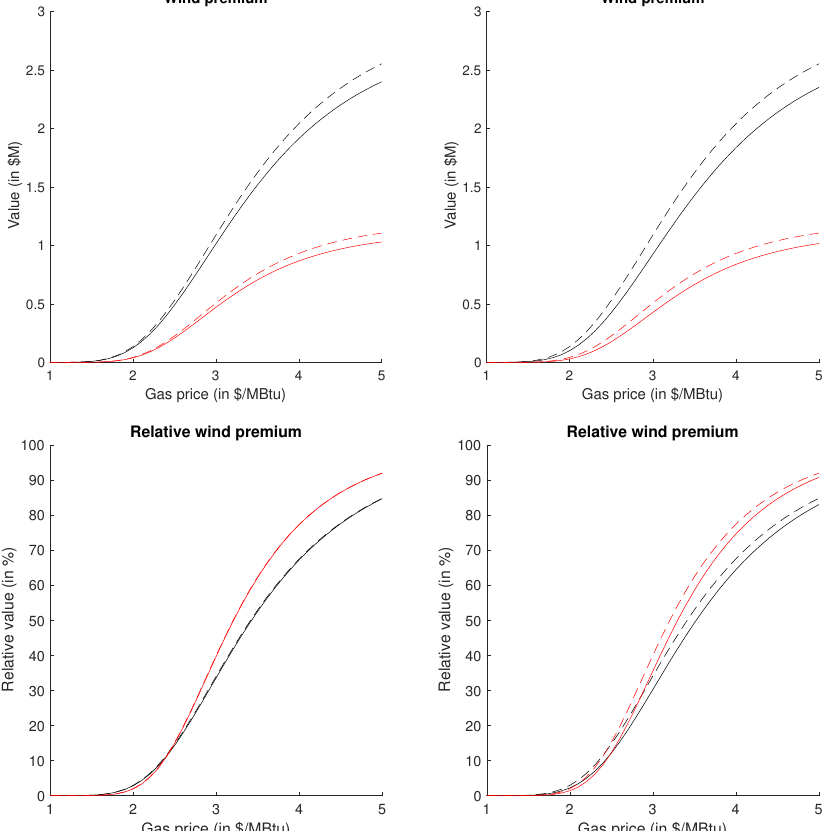
Figure 8. This figure displays the wind premium (upper panels) and relative wind premium (lower panels) at t = 0 (black) and t = 0.3 (red) in case of low sensitivity of the gas price ( C = 0, left panels) and of high sensitivity ( C = 2.5, right panels). The value of X t is 50$/MWh. Solid line corresponds to the pandemic case, dashed line to the no-pandemic case. Parameter values are given in Table